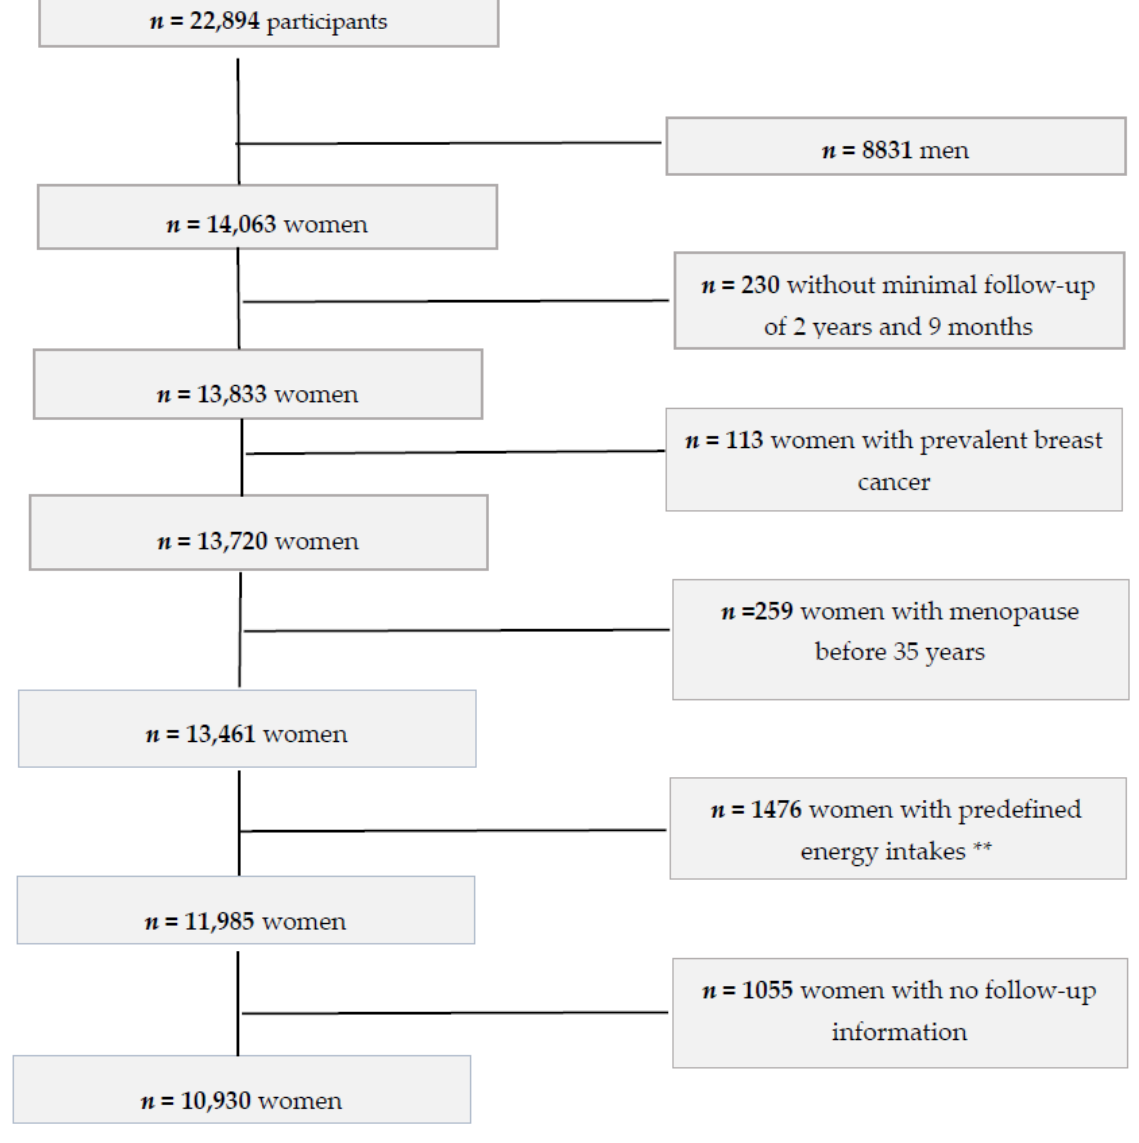
Figure 1. Flowchart representing the inclusion and exclusion criteria for the selection of participants of the SUN Project (“Seguimiento Universidad de Navarra”), included in this analysis. SUN Project, 1999–2019. * To ensure a 2 year and 9-months follow-up. ** Energy limits proposed by Willett (2013): 500–3500 kcal/day